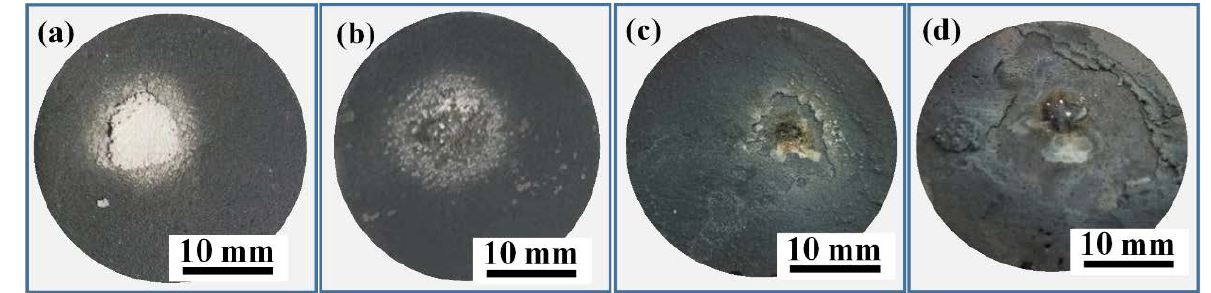
Table 4. The mass and linear ablation rate of S3 coatings after 60 s ablation.